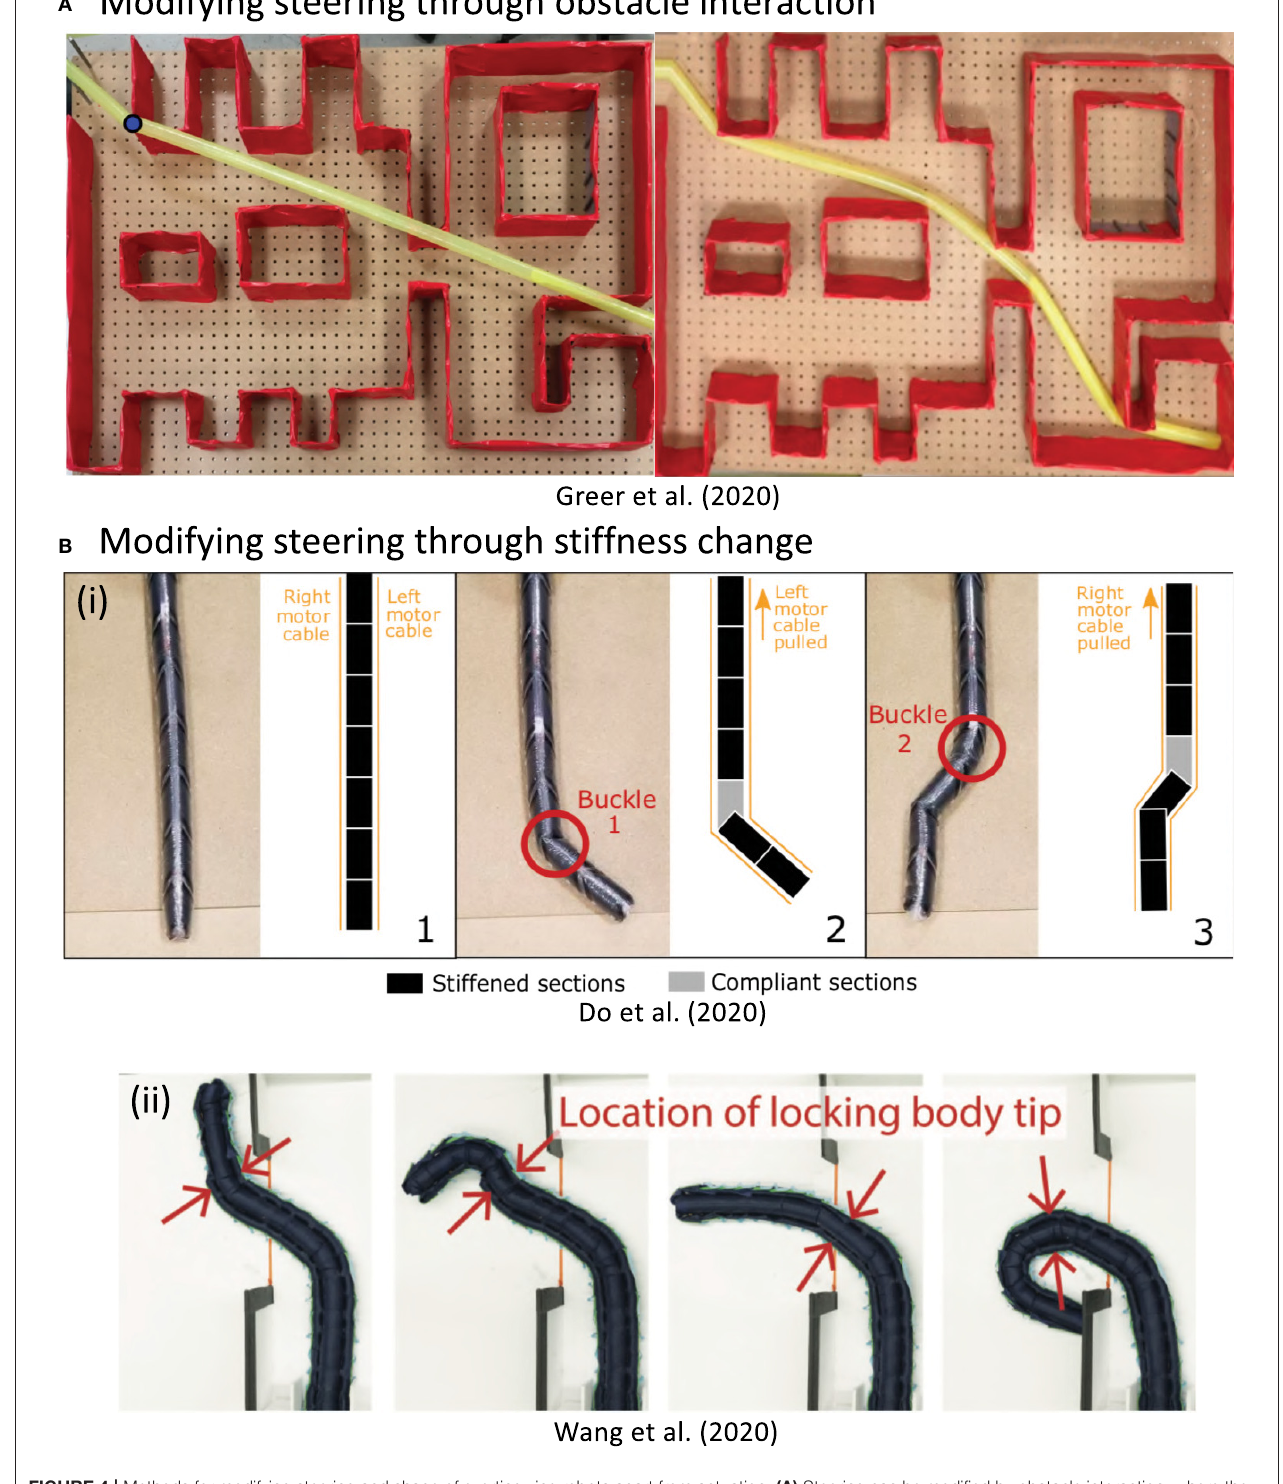
Frontiers in Robotics and AI | www.frontiersin.org